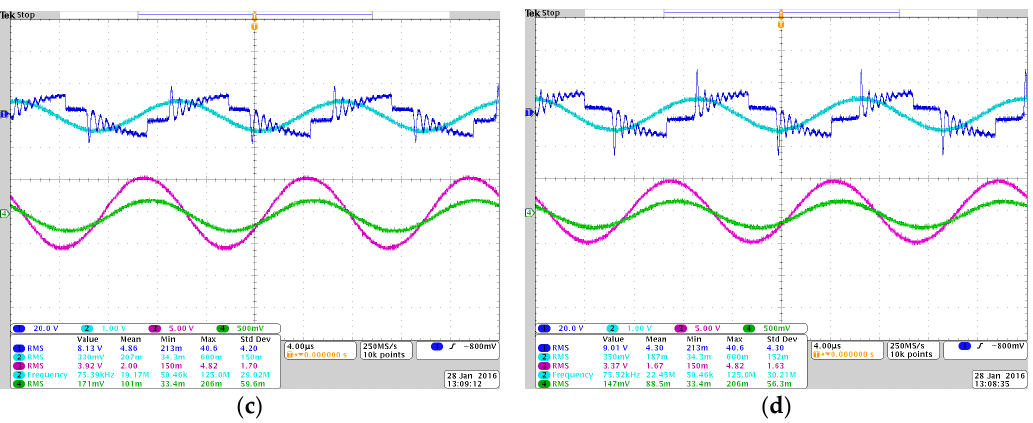
Figure 15. When the metal plate is 6cm away from the receiving coil, input current-voltage and output current-voltage waveforms vary with different numbers of cores: ( a ) without cores; ( b ) with 8 cores; ( c ) with 6 cores; ( d ) with 3 cores.